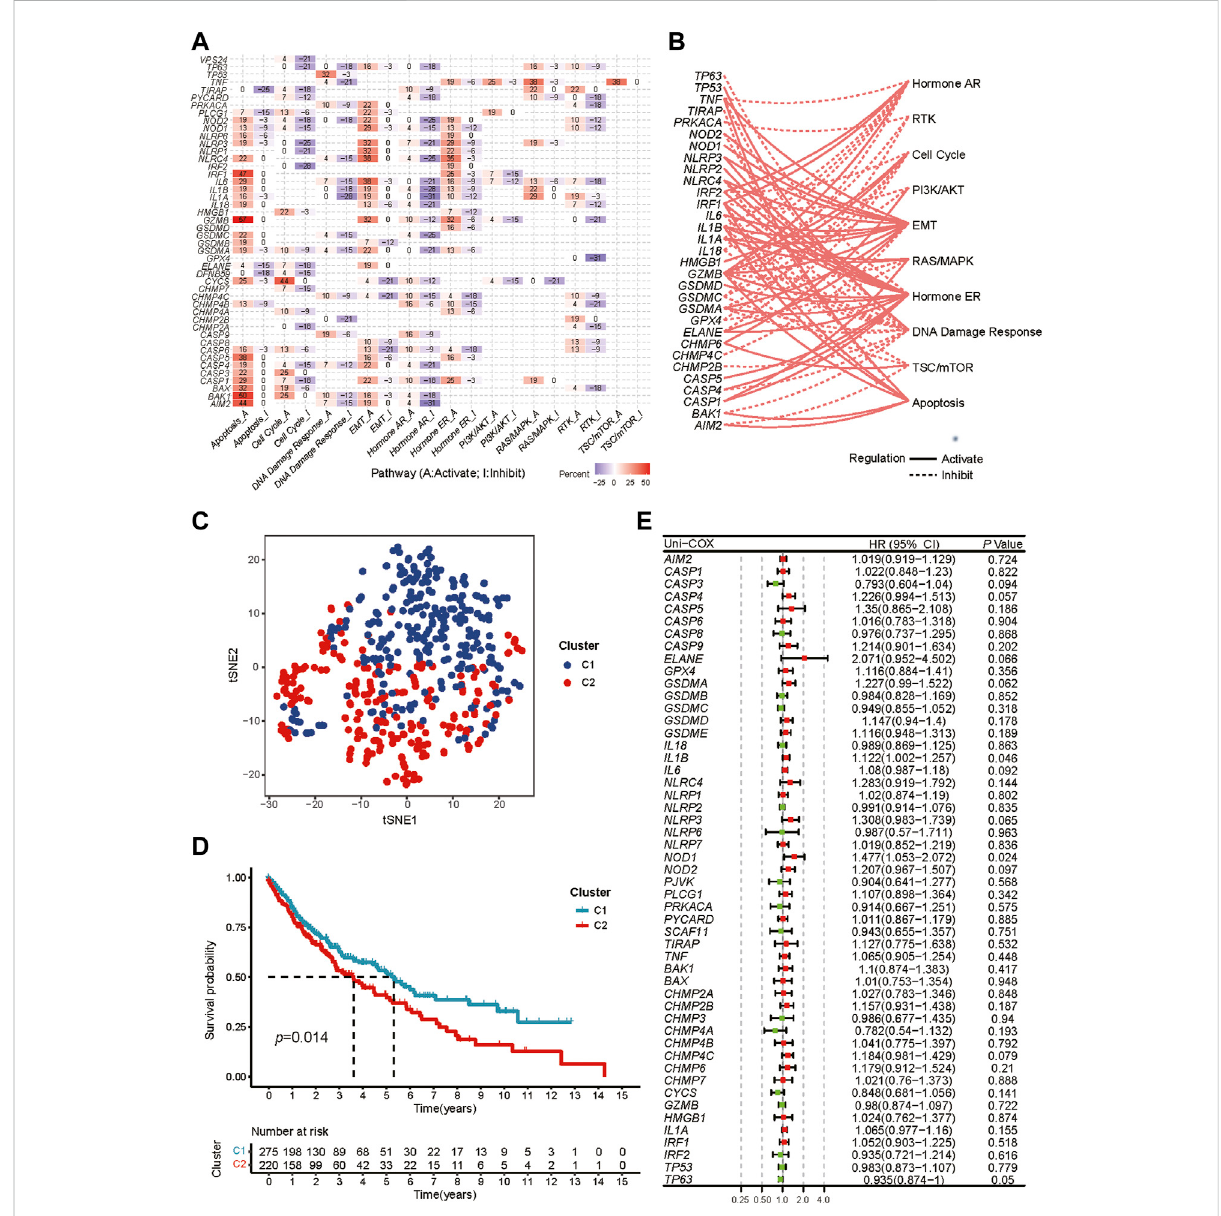
FIGURE 2 Exploration of two different expression patterns of pyroptosis-related molecules. (A) Heatmap depicts the association between pyroptosis- related genes expression levels and essential cancer signaling pathways. The percentage is the total proportion of tumors in which a gene has an in fl uence on the pathway among the 32 cancer types (number of inhibited or activated cancer types/32 *100%). Pyroptosis genes that have a role (inhibit or activate) in at least fi ve cancer types are included in this heatmap. The percentage of tumors in which a pathway may be inhibited by speci fi ed genes is represented by “ pathway inhibit ” (blue), whereas activation is represented by “ pathway activate ” (red). (B) The correlation between the pyroptosis-related genes in LUSC and essential cancer signaling pathways. The dotted line indicates inhibition, whereas the solid line indicates activation. (C) t-SNEplotshows twodifferentpyroptosis expressionpatterns represented bytheexpression ofpyroptosis-related genes. (D) Kaplan- Meier curves for the OS between two distinct pyroptosis expression patterns. (E) Univariate Cox analysis to explore the prognosis value of each pyroptosis-related genes for